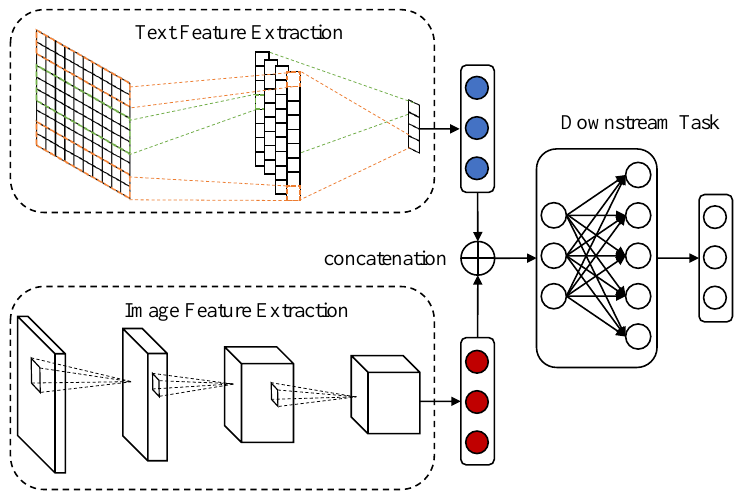
Figure 2. A simple and common method for representation fusion is to concatenate feature vectors extracted by different pre-trained